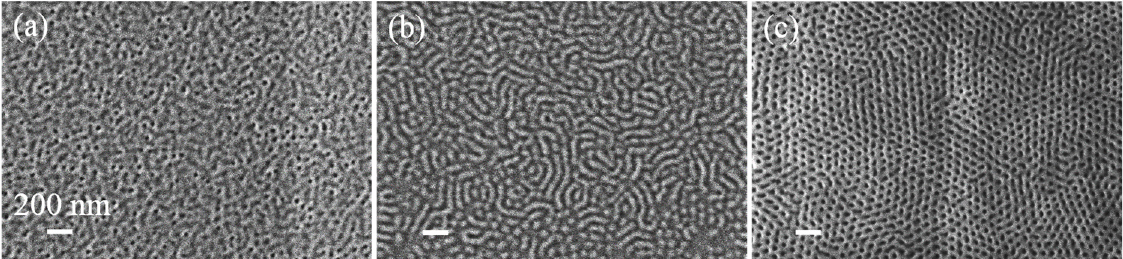
Figure 3. SVA of PS- b -PMMA 140k-b-65k on PG4 76%/SiO 2 /Si substrates. SEM images after 15 min of BCP SVA using: ( a ) chloroform, ( b ) acetone, and ( c ) THF.